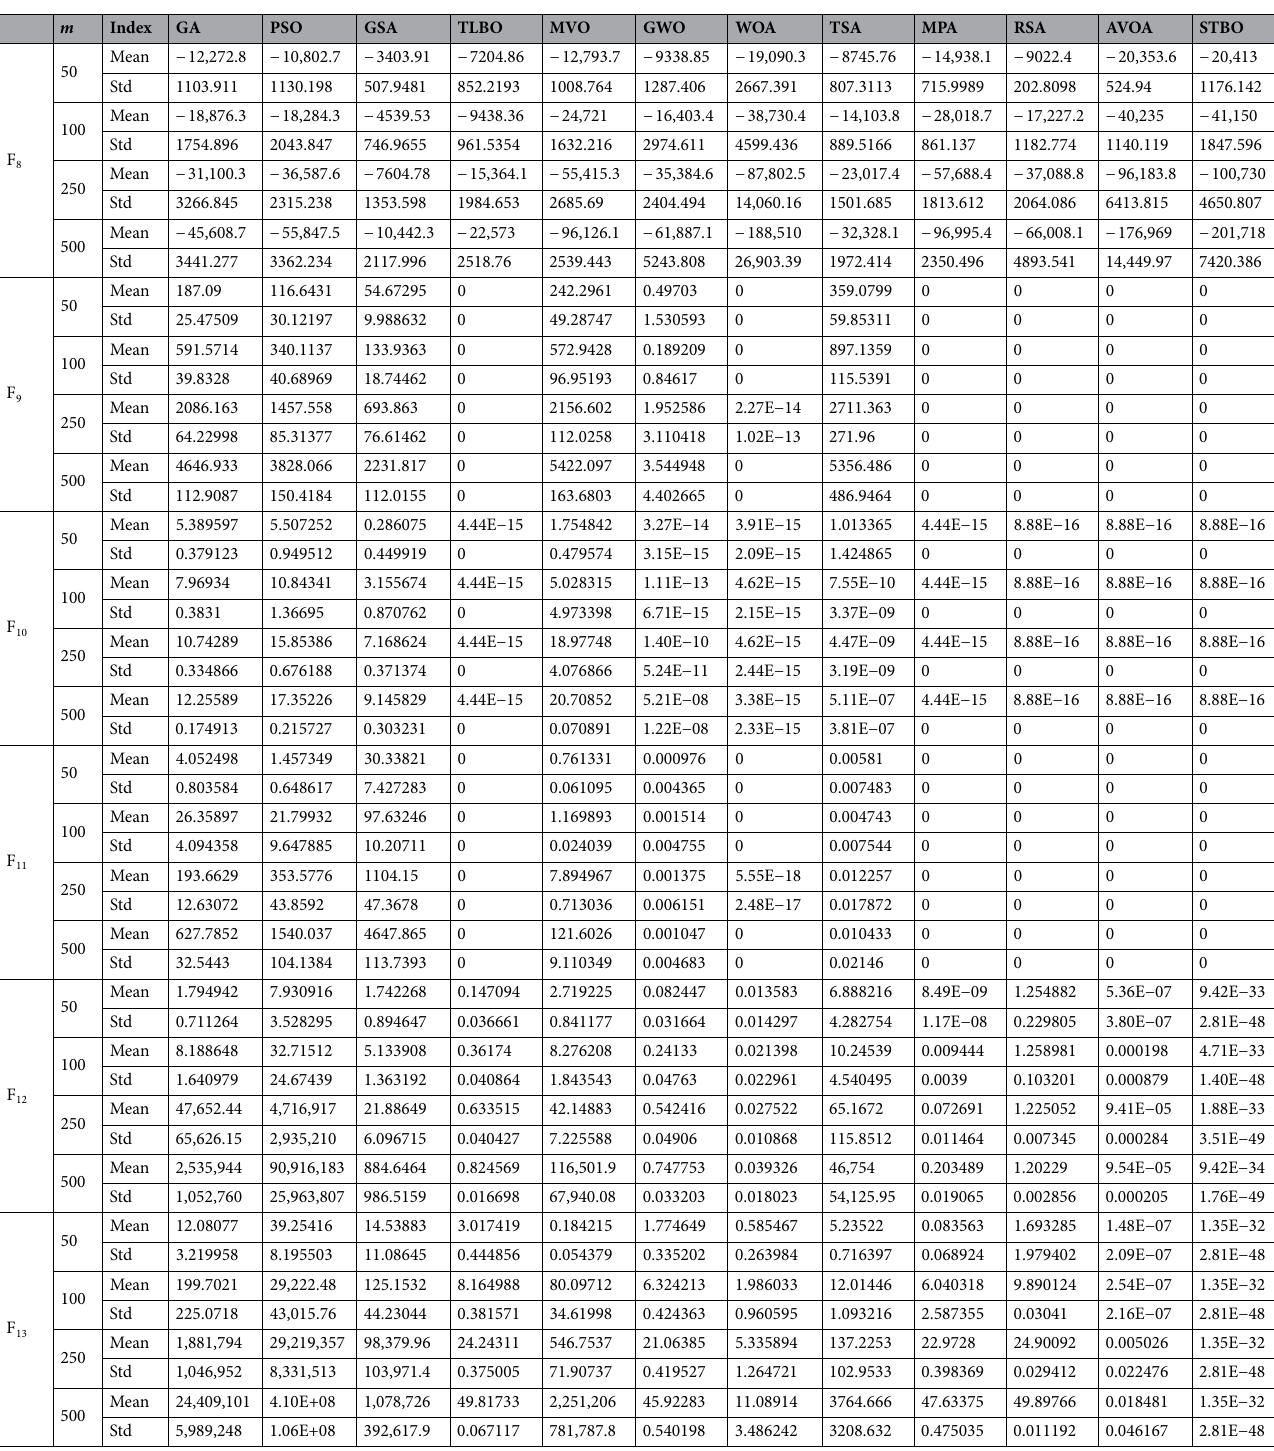
Table 7. The results of the scalability analysis of